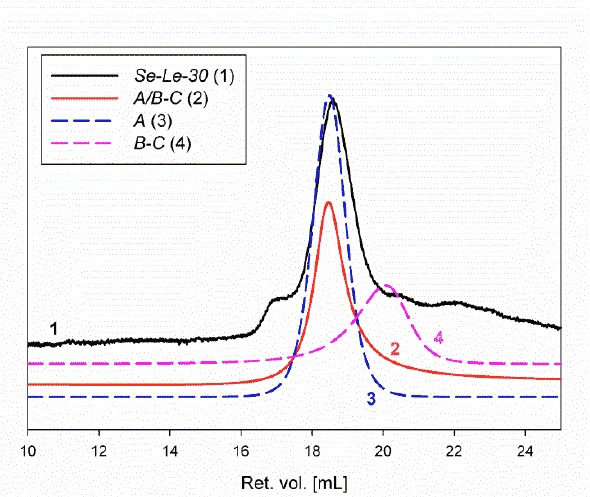
Figure 3. Refractive index (RI) traces from SEC of the Se-Le-30 , A (I), A/B-C (II), and B-C (III) fractions. The lines for the A , A/B-C , and B-C fractions were smoothed to remove